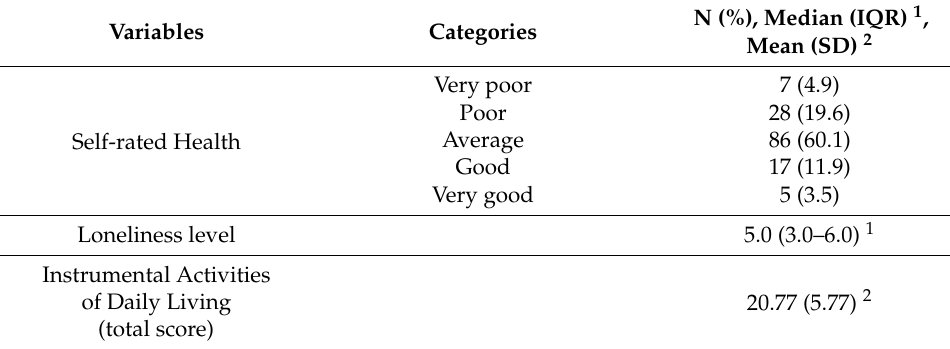
Table 2. Ratings of the subjects ( n =